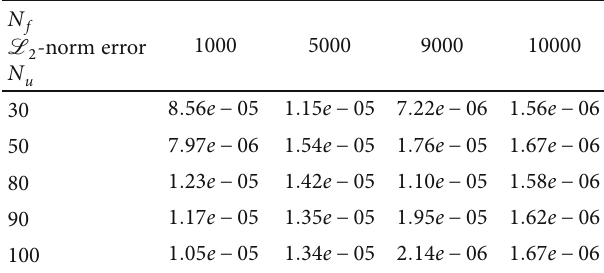
Table 2: mkdv equation: L 2 -norm error between the predicted and exact solutions of u ð t , x Þ for DNN architecture which is constructed by 9 hidden layers with 20 neurons per hidden layer with di ff erent training points N u and collocation points N f